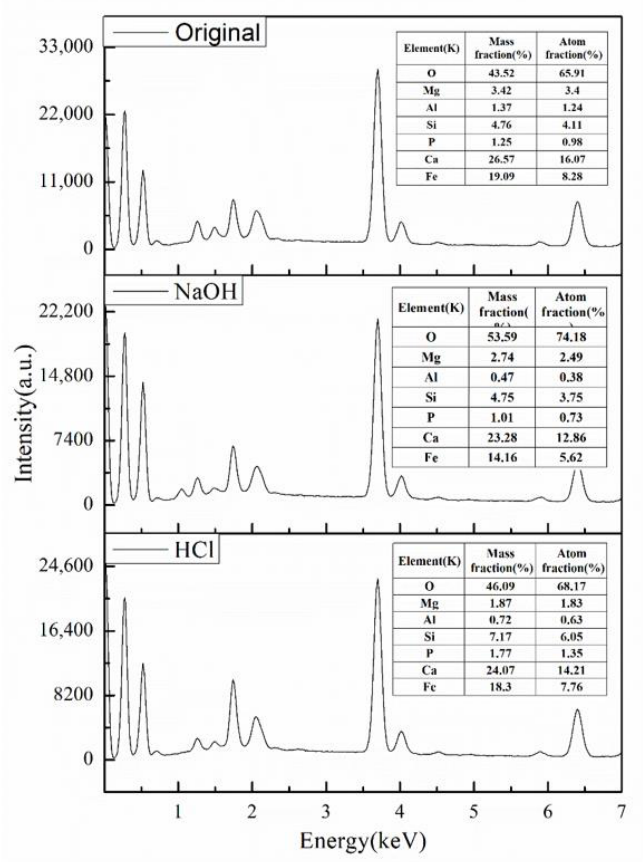
Figure 9. Energy spectrum analysis of the sample before and after